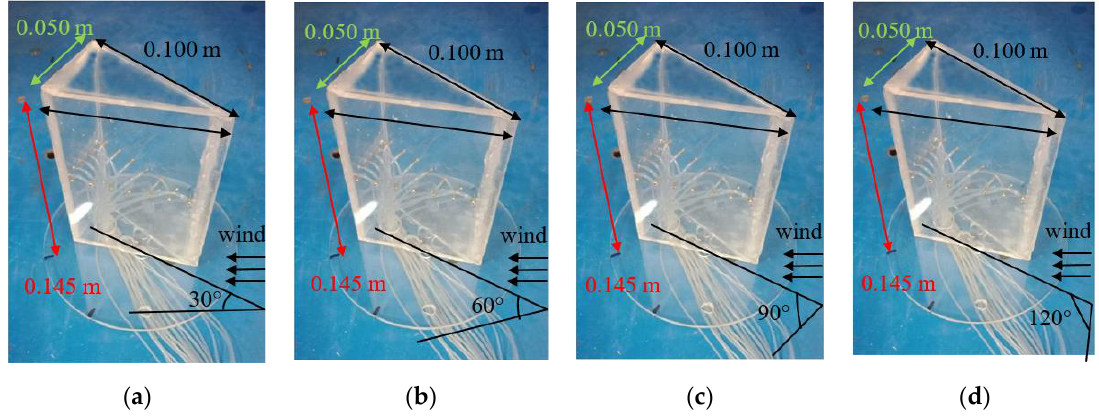
Figure 5. Prism model used in the transiting tests. ( a ) 30° Angle of attack, ( b ) 60° Angle of attack, ( c ) 90° Angle of attack, ( d ) 120° Angle of attack.